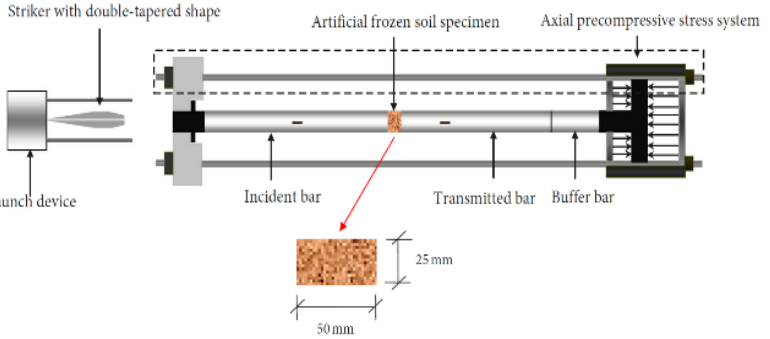
Figure 15. Modified SHPB test stand with frozen soil specimen - silty clay (reprinted from Ref. [80]).